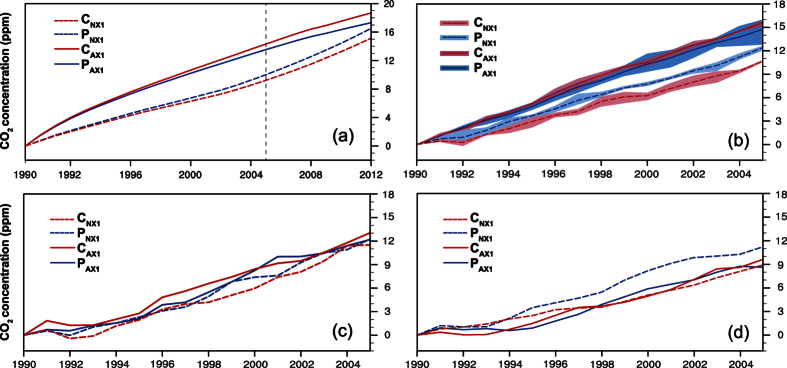
Temporal evolution of the simulated atmospheric CO2 concentration changes relative to 1990 using (a) IRF, (b) CESM, (c) BNU-ESM and (d) FGOALS-s2 under the PAX1, PNX1, CAX1 and CNX1 scenarios. (b) Shading shows the range of CO2 changes due to different initial conditions and lines are the ensemble mean.